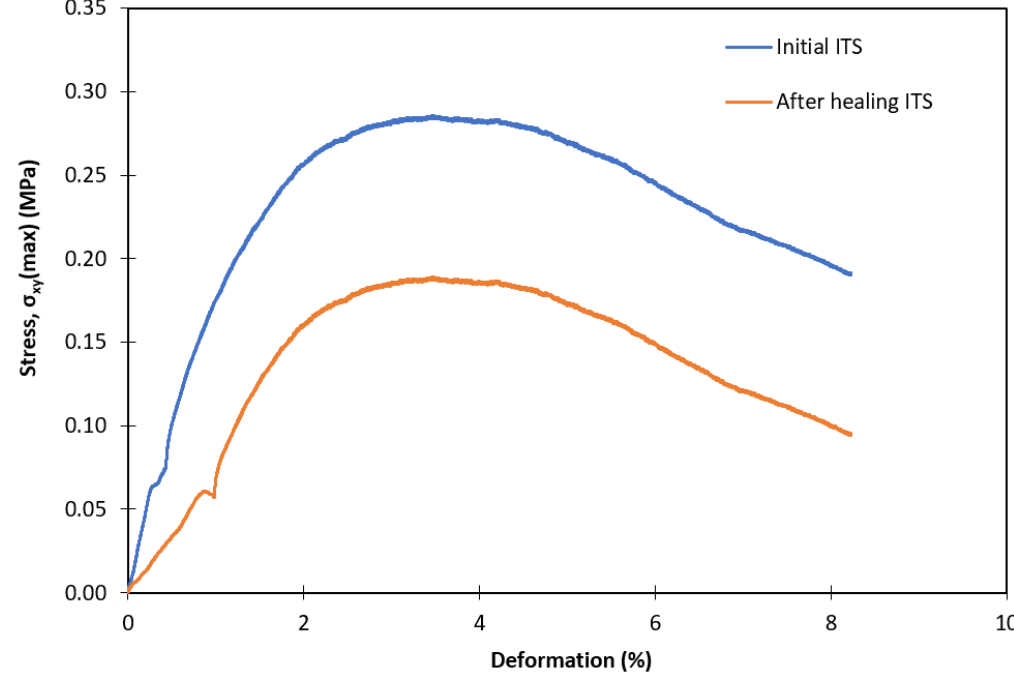
Figure 23. Mortar mix strength for ITS test specimens containing 5% capsules recovery after 5 min of induction healing.